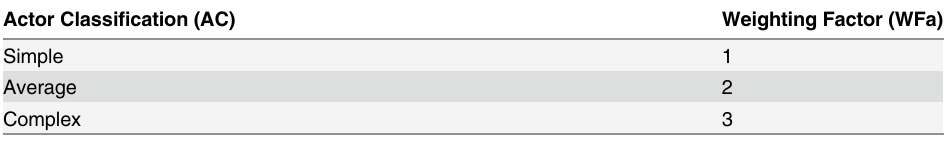
Table 1. Actor Classification and Actor Weighting Factor.